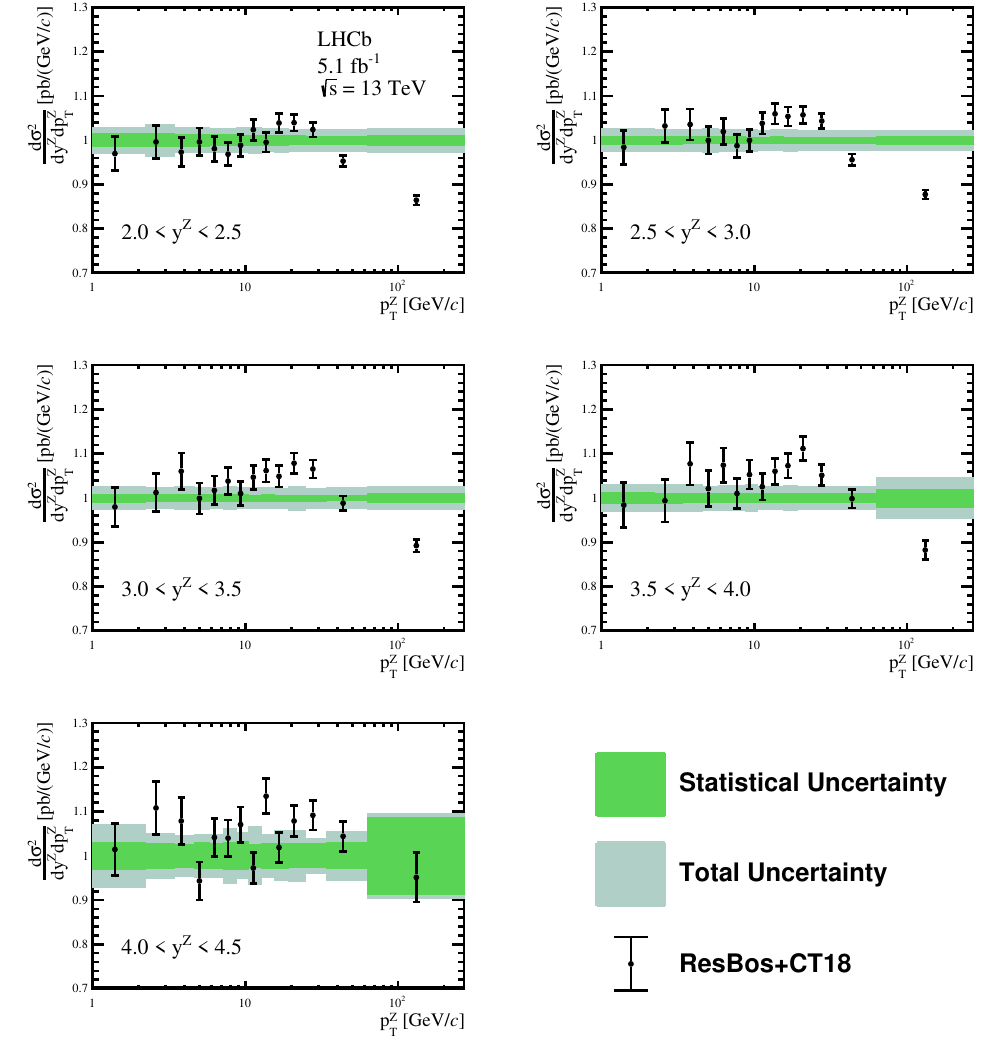
Figure 7 . Ratios of ResBos predictions to measurements as a function of p Z with the horizontal bars showing the uncertainty from the